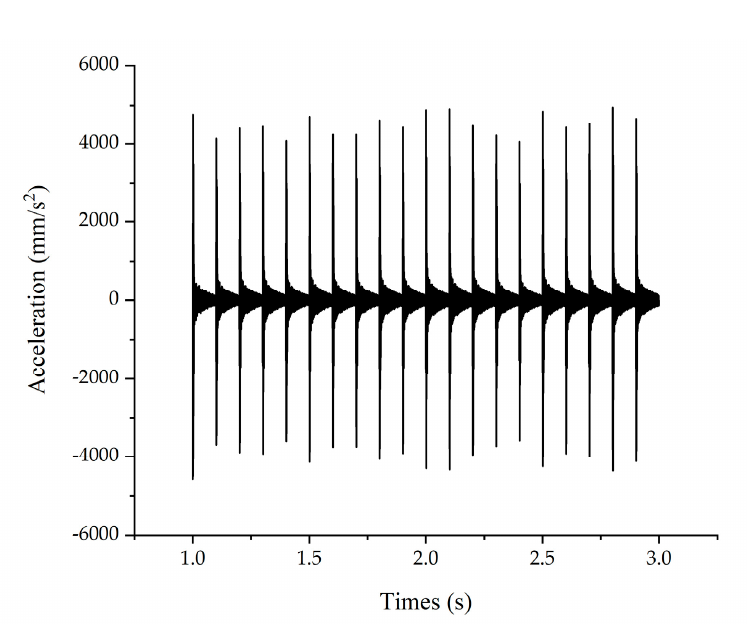
Figure 14. Acceleration response of random variable amplitude continuous impulse excitation.